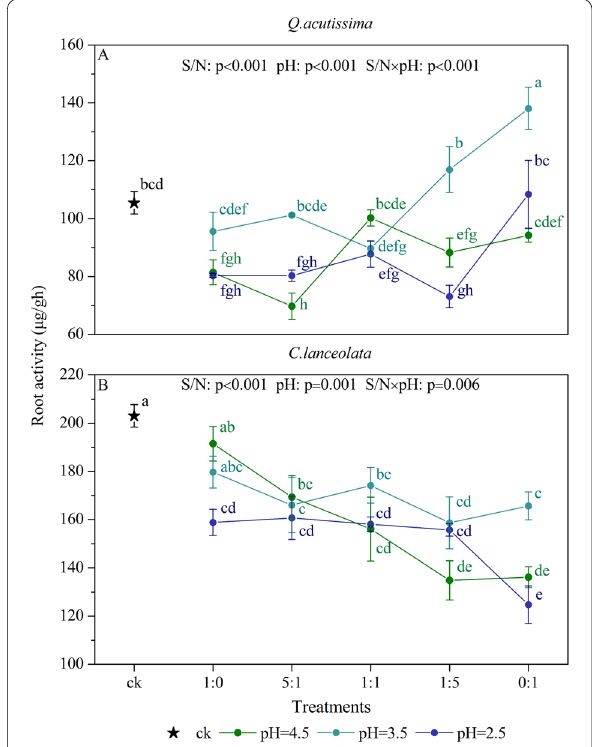
Fig. 4 Variations in the root activities (TTC) between treatments. Different ratios represent the AR S/N ratio and different colors represent AR pH. The analysis and the meaning of the letters are consistent with Fig.